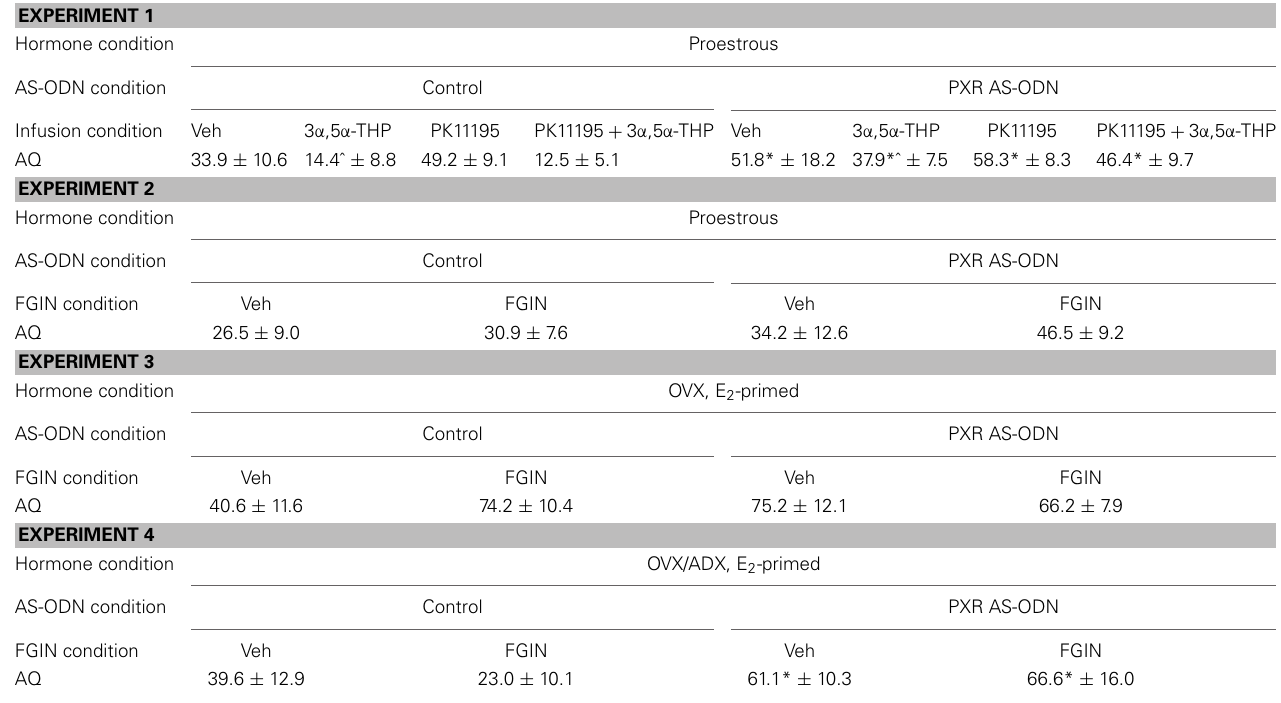
Validation of PXR AS-ODNs for PXR expression in the